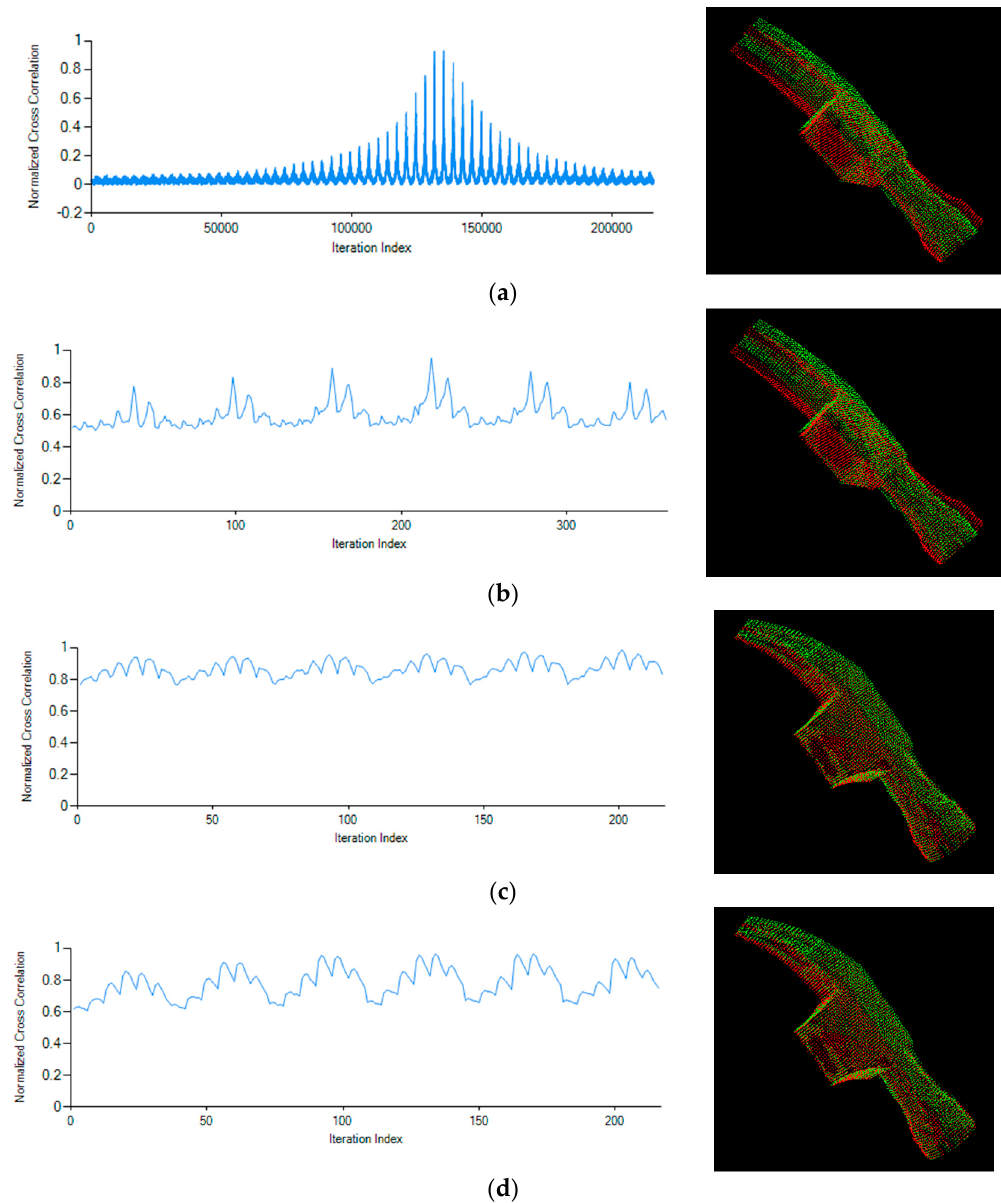
Figure 9. Normalized cross ‐ correlation curves given by Equation (11): ( a ) the coarse registration with rotation Δθ = π /60 and α thresh = π ; ( b ) the coarse registration with rotation Δθ = π /60 and α thresh = π /10; ( c ) the coarse registration with rotation Δθ = π /180 and α thresh = π /30 (OBB segments: k 1 × k 2 × k 3 = 4 × 5 × 6); ( d ) the coarse registration with the rough rotation estimate before a rotation increment Δθ = π /180 and α thresh = π /30 (OBB segments: k 1 × k 2 × k 3 = 9 × 10 × 11).